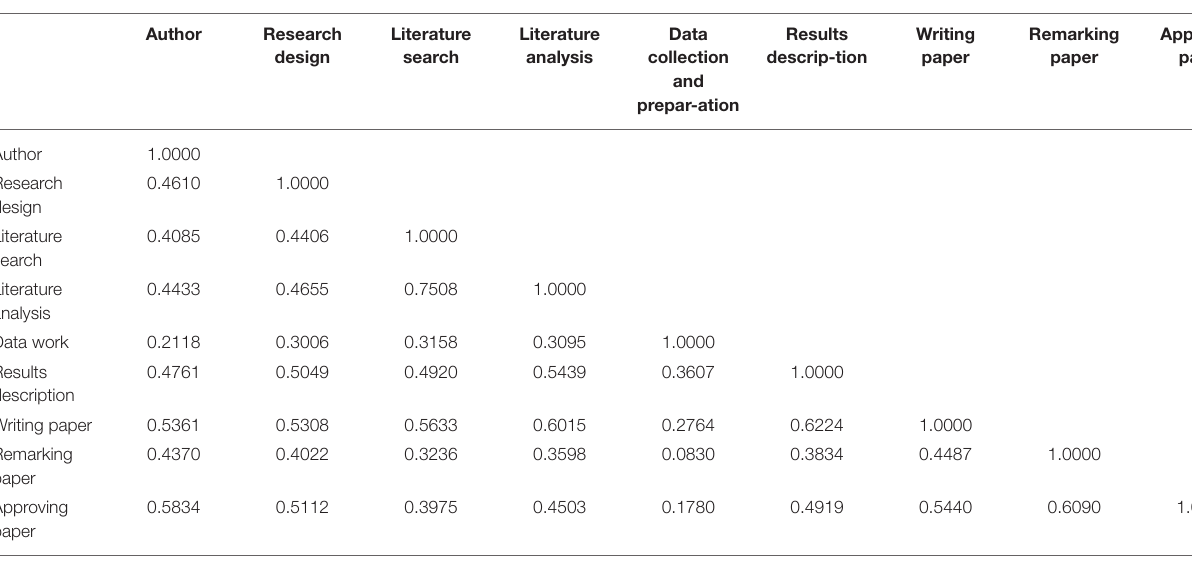
TABLE 4 | Correlation matrix of research